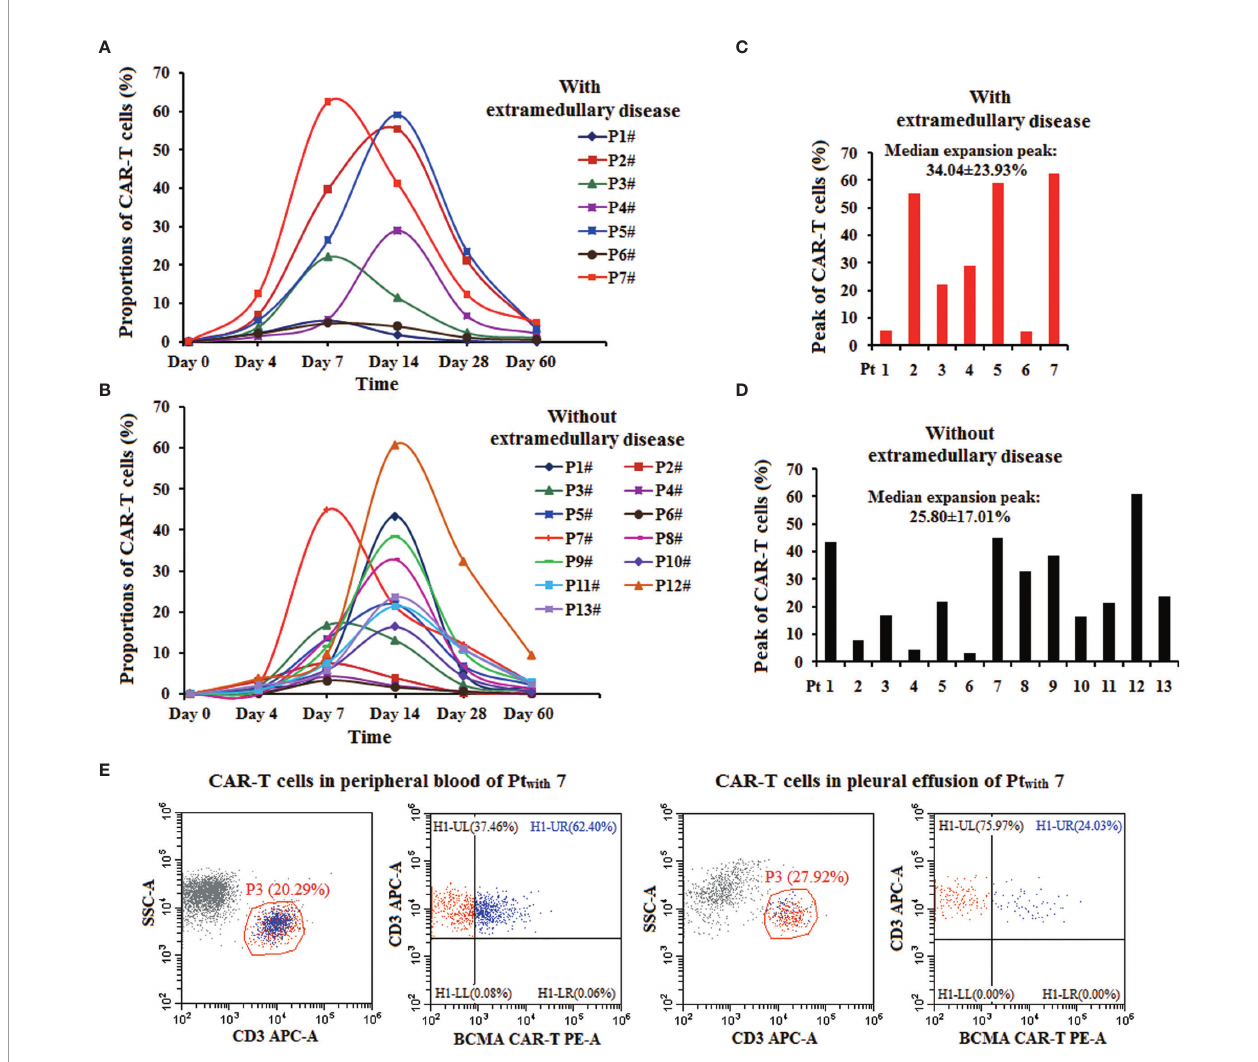
FIGURE 4 | The proportions of the anti-BCMA CAR-T cells in the therapy. (A, B) . The proportions of anti-BCMA-CAR T cells in CD3+ T cells in peripheral blood in the two group of patients. (C, D) . There was no difference in the median expansion peak of the anti-BCMA CAR-T cells in CD3+ T cells in peripheral blood in the two group of patients ( P = 0.438). (E) . In Pt with 7, the highest anti-BCMA CAR-T cell expression in peripheral blood was 62.4%, the level of anti-BCMA CAR-T cells in her pleural effusion was